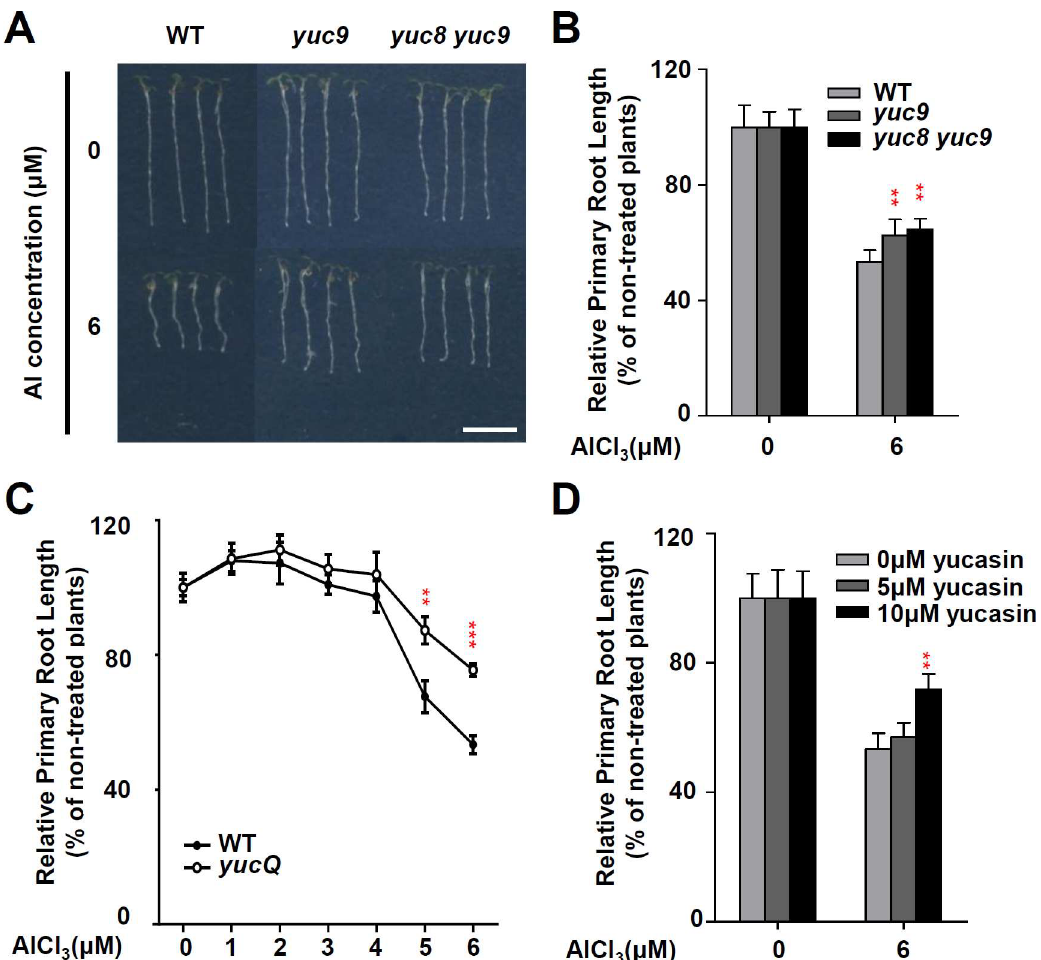
Fig 1. YUC regulates Al stress regulated root growth inhibition. (A, B) Root growth of WT and yuc mutant seedlingsafter a seven-dayexposure to 0 or 6 μ M AlCl 3 . Three independent experiments were done, each with three replicates. Plants were grown at 22˚C in long-daygrowth conditions. Bar = 1 cm. (C) Root growth of WT ( DR5rev : GFP ) and yucQ/DR5rev : GFP plants after a seven-day exposure of 0 to 6 μ M AlCl 3 . (D) Effect on the Al-inducedinhibitionof root growth of WT by additionthe YUC inhibitor yucasin. Root growth measured after a seven-day exposure to 0 or 6 μ M AlCl 3 in the presence of 0 to 10 μ M yucasin. Three independent experiments were done, each with three replicates. Error bars represent Student’s t test confidence intervals (n = 9). Statistical differencefrom expected indicatedby asterisks (Fisher’s exact test, ** P < 0.01, *** P < 0.005).